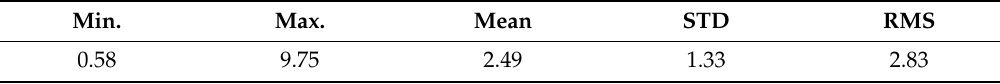
Figure 5. Comparison between error of the INS-indicated location and the error of the matched location. Table 3. Statistical results of matching and location errors (unit: n mile).